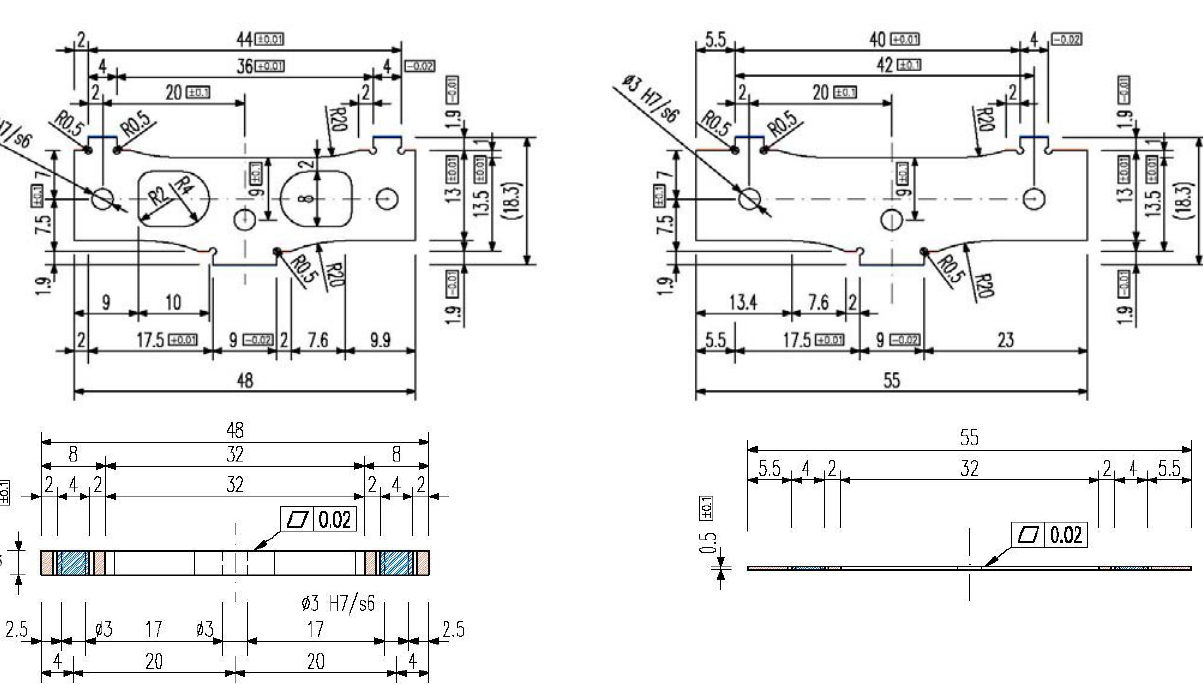
Figure 8. The new WIM shear beam sensor